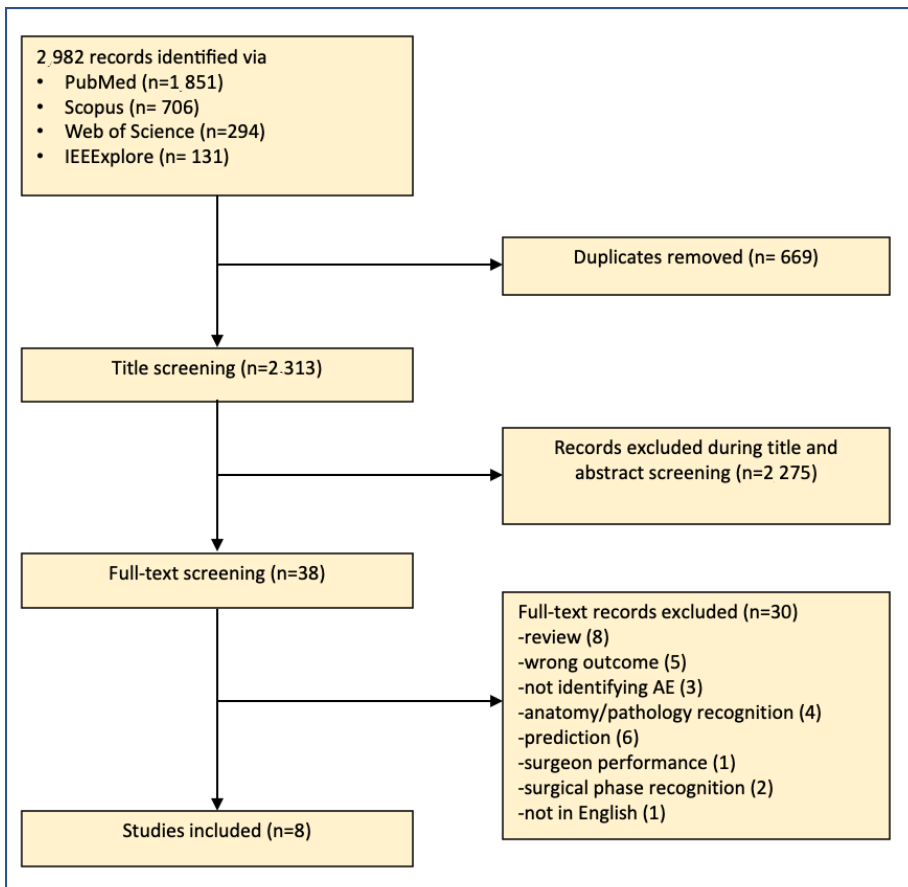
Figure 1. Flow diagram: study identification and screening process.